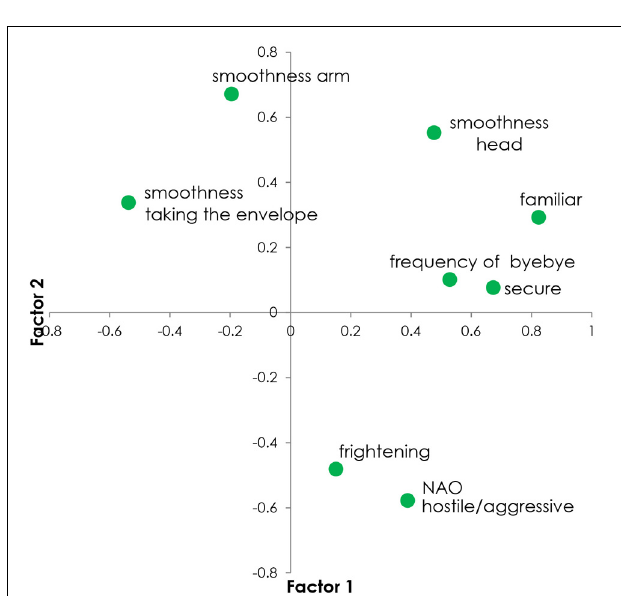
FIGURE 6 | Scatter plot (or Biplot) of the two first Principal Components (Factor 1 and Factor 2) of the Principal Component Analysis (PCA) of the affective/emotional variables and the motion variables examined in our hypotheses.